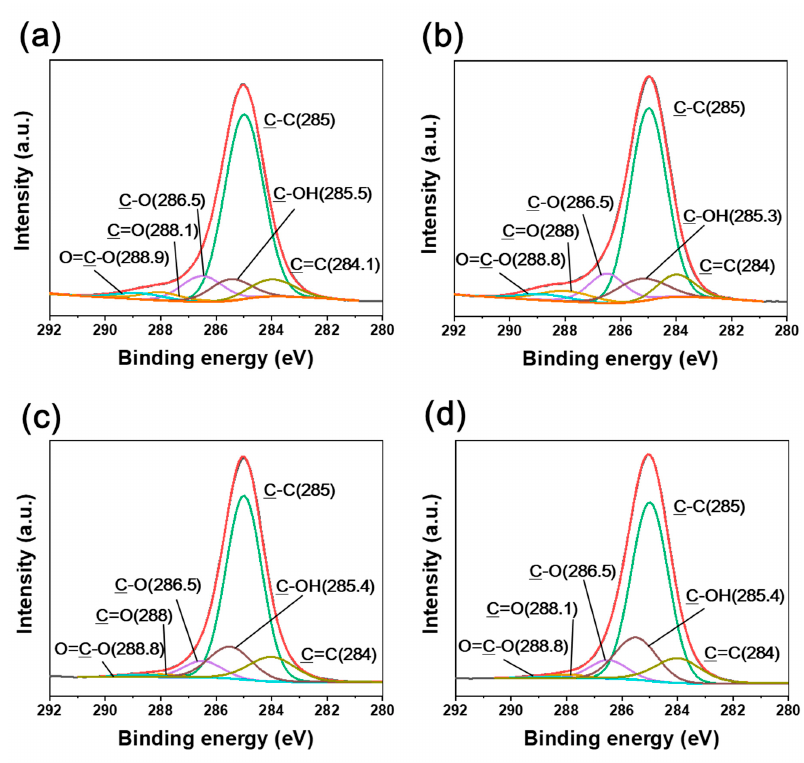
Figure 6. C1s XPS spectra of natural HDPE irradiated at ( a ) 3.4 kGy/s, ( b ) 6.8 kGy/s, ( c ) 13.5 kGy/s, and ( d ) 27 kGy/s absorbed dose rates. Polymers 2020 , 12 , x FOR PEER REVIEW